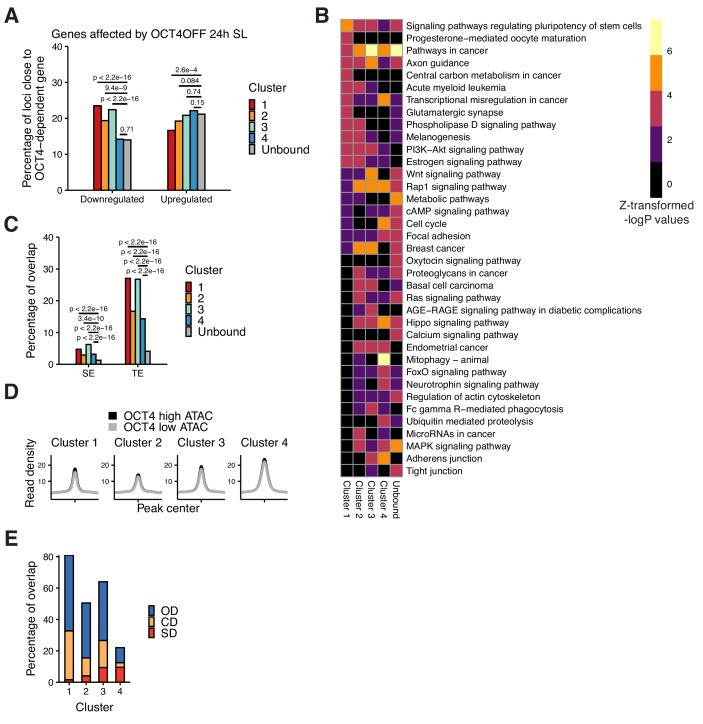
Additional analyses of clusters.(A) Percentage of the closest gene in the clusters from Figure 3D and at non-OCT4 bound accessible regions whose nascent RNA levels are downregulated or upregulated upon 24 hr of OCT4 depletion. p-values: Fisher’s exact test. (B) Relative enrichment values (Z-transformed –logP) for the closest genes in the clusters from Figure 3D and at non-OCT4 bound accessible regions, in all KEGG gene ontology sets with Z > 3, sorted by enrichment in cluster 1. (C) Percentage of loci in the clusters from Figure 3D and at non-OCT4 bound accessible regions overlapping typical enhancers (TE) and super-enhancers (SE) in mouse ES cells. (D) RPKM-normalized ATAC-seq signal in cells sorted for high and low endogenous OCT4 levels 2 kb around loci in the clusters from Figure 3D. Statistics are available in Supplementary file 1. (G) Percentage of loci in the clusters from Figure 3D overlapping OD, CD, and SD loci from Figure 1C.